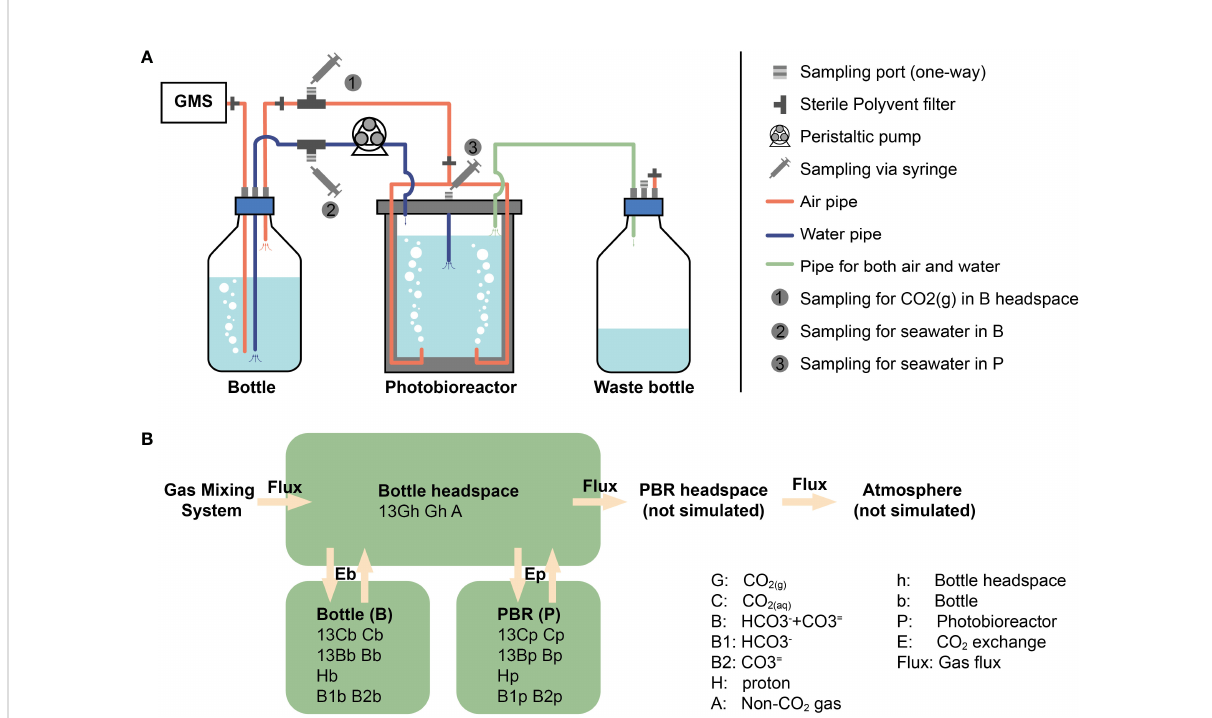
FIGURE 1 The photobioreactor system with CO 2 bubbling and model structure. (A) The photobioreactor system in Climate Geology laboratory, ETH Zurich. GMS means Gas Mixing System. (B) Our model consists of three compartments: bottle headspace, bottle media and photobioreactor media (words in bold). PBR is the photobioreactor. The other terms are simulated amount/concentration of substance, in which capital letters represent substance and subscript letters are abbreviation for